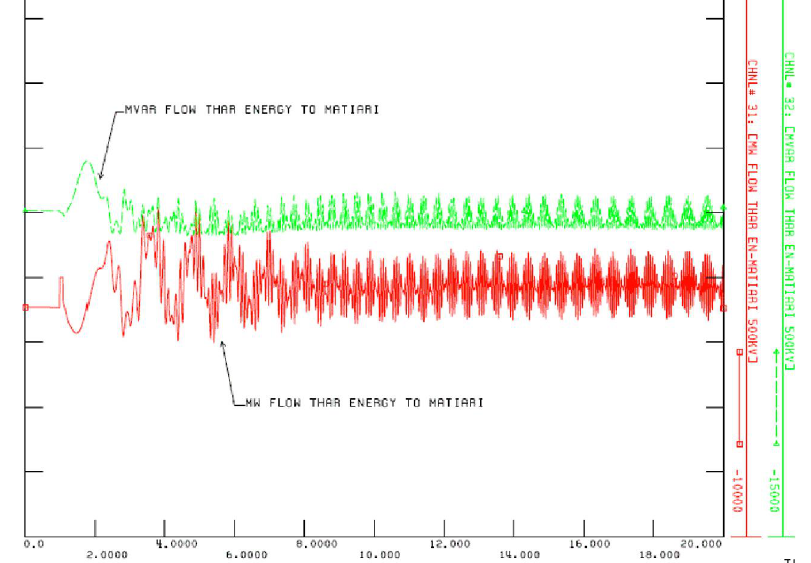
FIG. 11(c). MW AND MVAR FLOWS